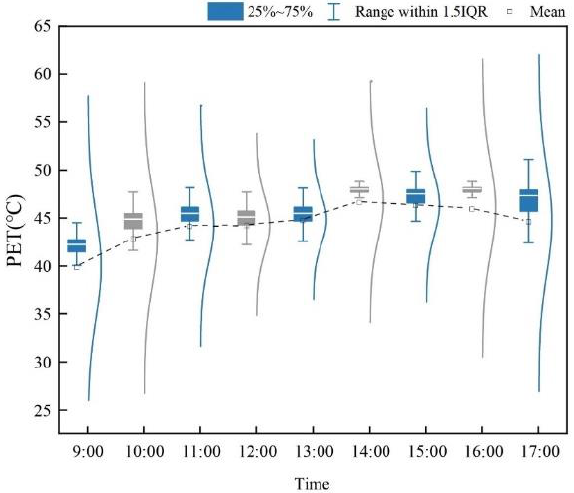
Figure 6. PET variations at different